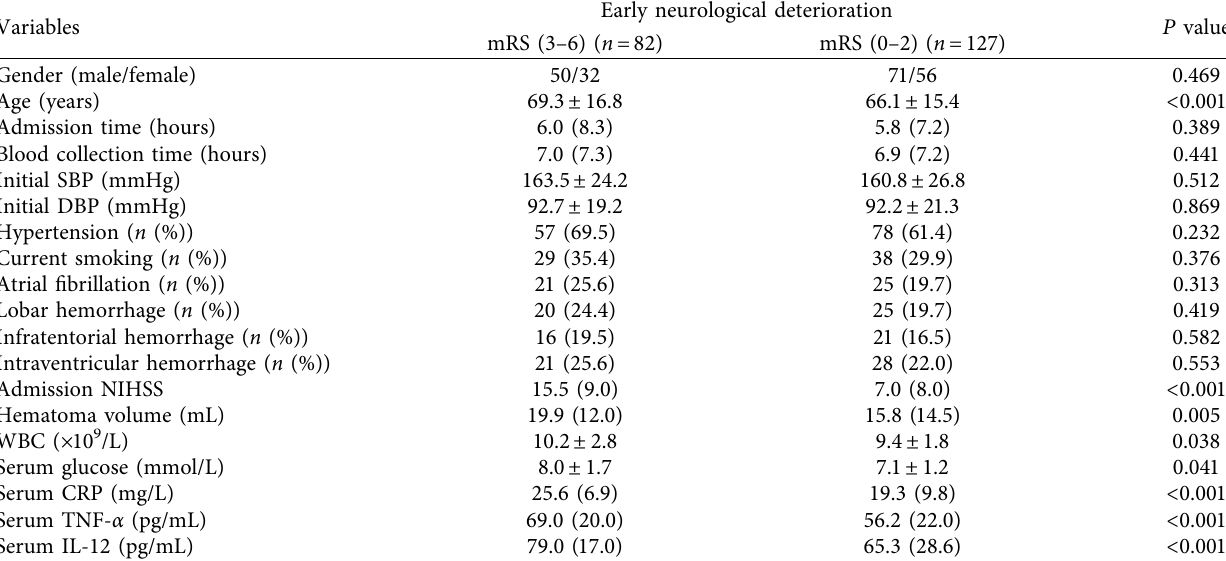
Table 4: Factors associated with 3-month poor outcome in patients with ICH.